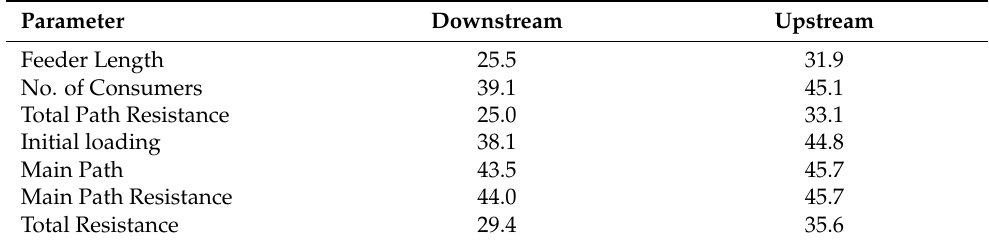
Table 5. Standard error of regression for each